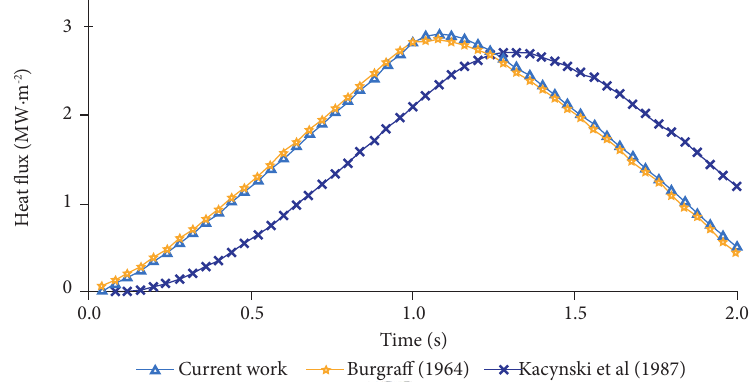
Figure 6. Comparison between Kacynski et al. (1987), Burggraf (1964) analytical correlation, and the solution for IP of this work. One can note good agreement between the current work and Burgraff (1964) solution. The Kacynski et al. (1987) solution presents a delay, possibly due to the assumption of temperature derivative with respect to time and not with respect to the